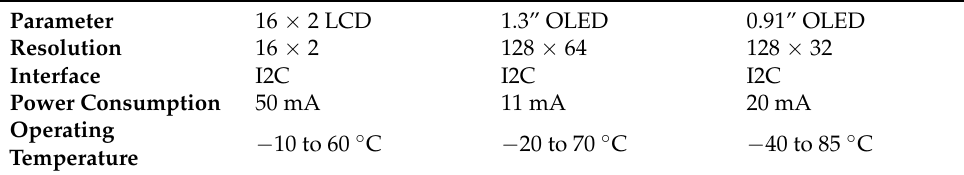
Table 5. Display hardware